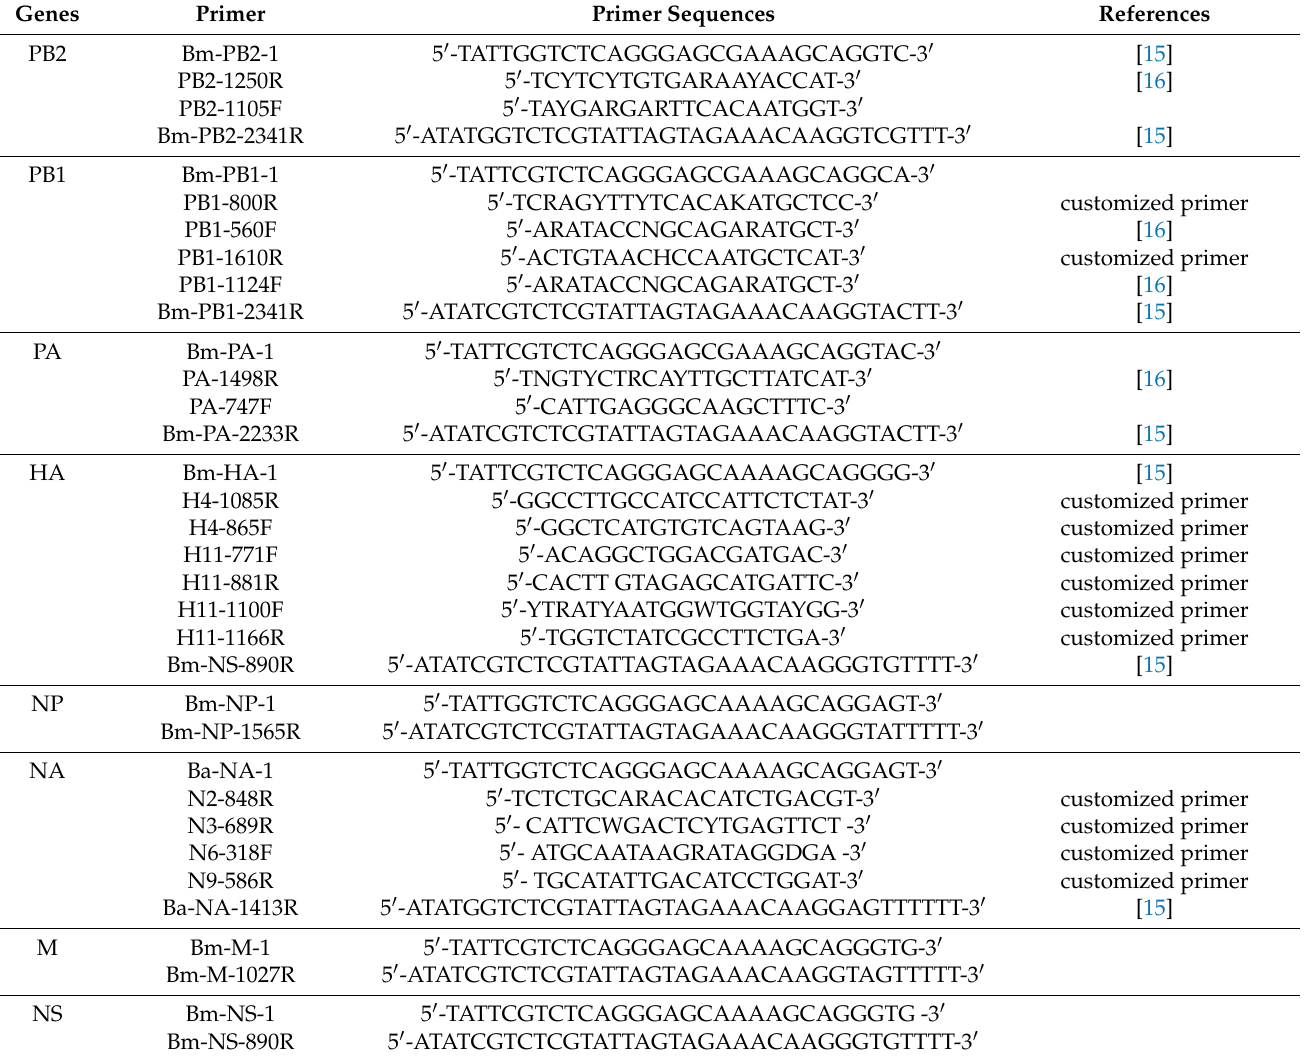
Table 1. PCR primers for H4 and H11 avian influenza virus